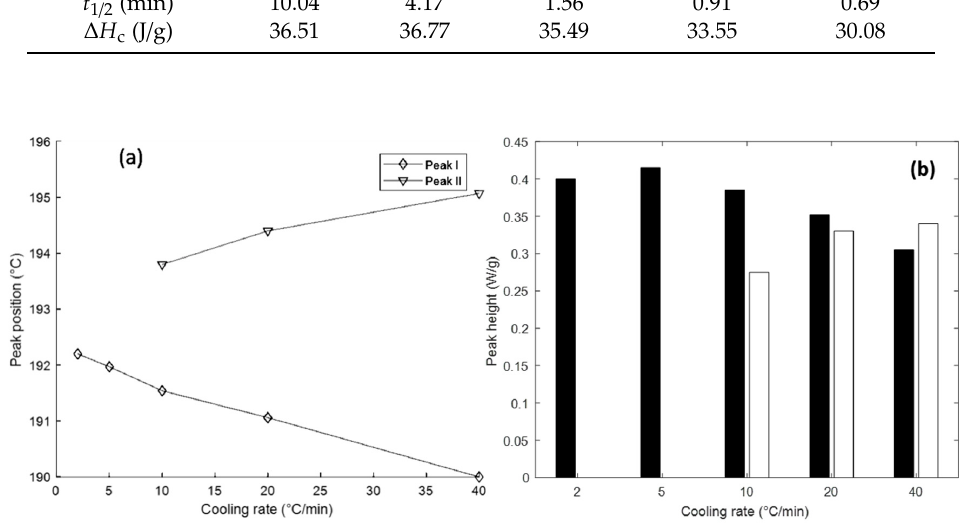
Figure 3. Peak positions and magnitude ratios for the non-isothermal crystallisation: ( a ) the evolution of peak centre temperature values, and ( b ) peak heights as a function of the cooling rate.